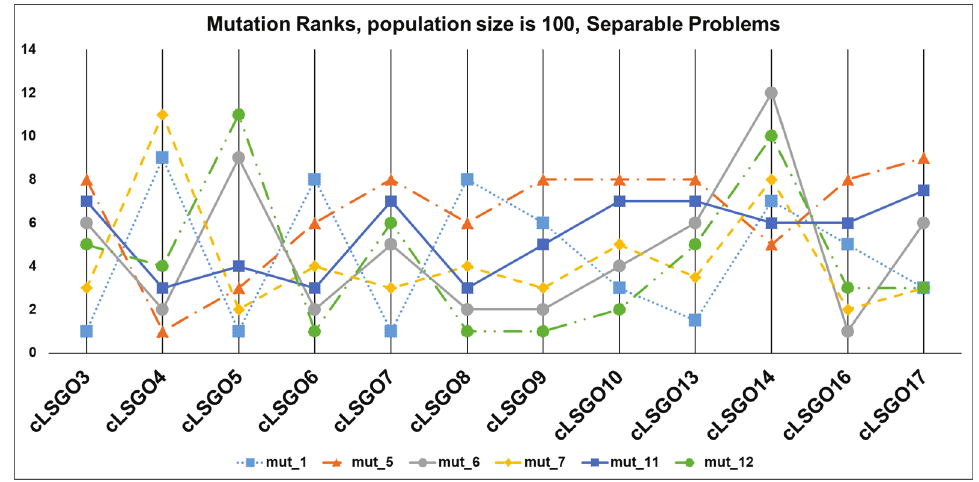
Figure 17. The ranking of ε -iCC-SHADE with some mutation strategies for separable problems.